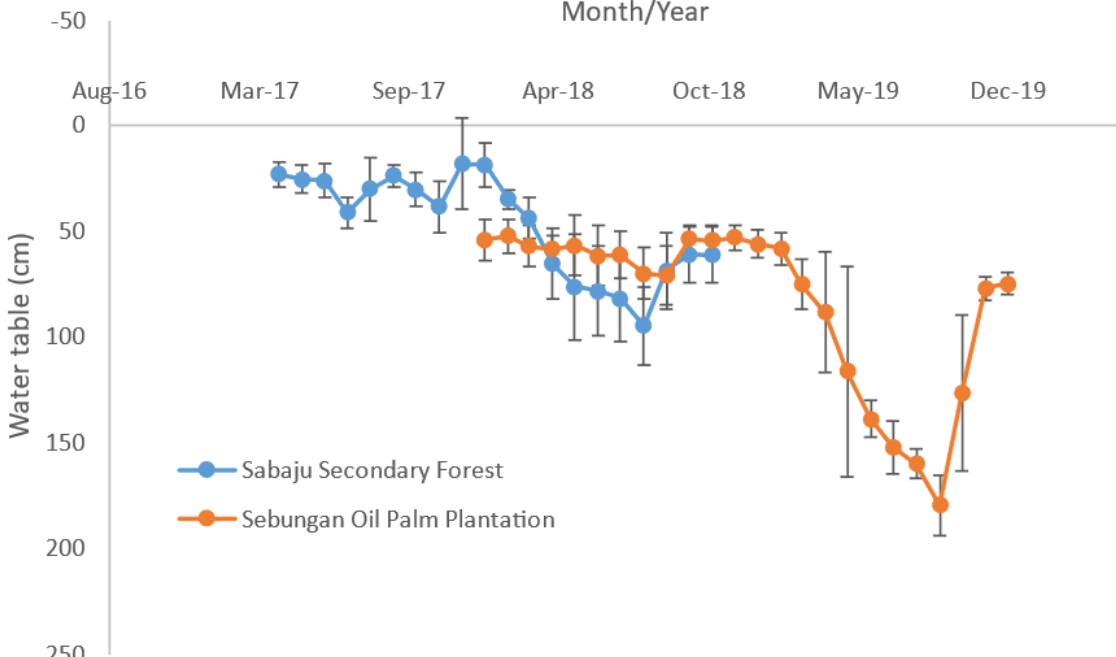
Figure 10. Monthly water table data collected in Sebungan Estate oil palm plantation (2018–2019) and Sabaju secondary tropical peat swamp forest